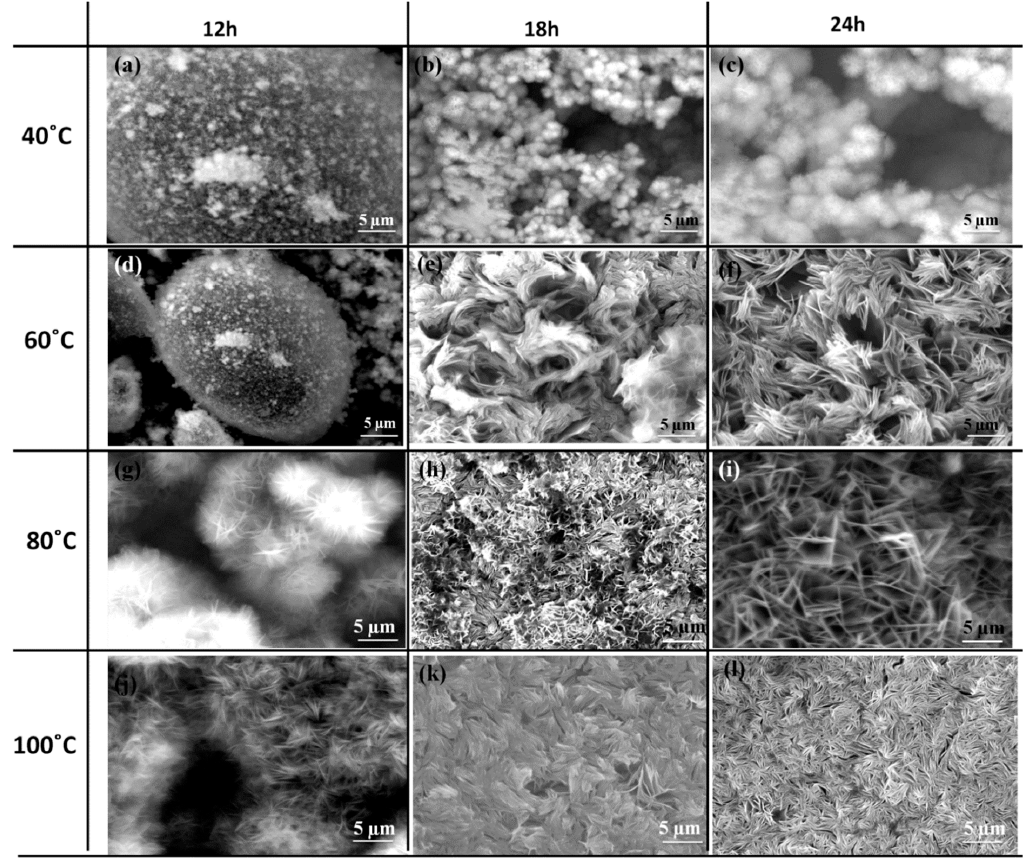
Figure 4. SEM images of LDH films developed at various reaction temperatures and crystallization